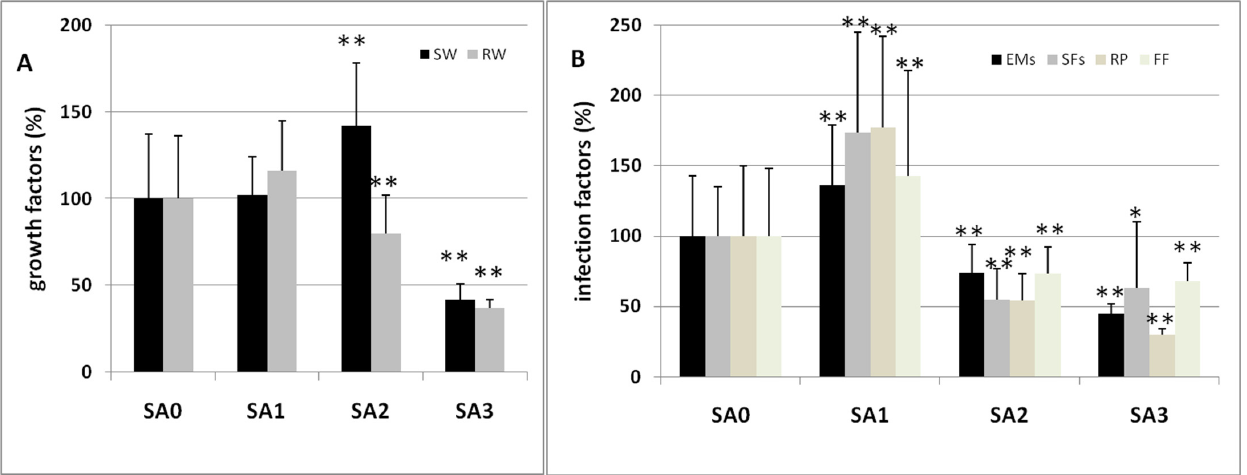
Figure 3. Effects of sprayed SA on plant growth ( A ) and nematode infection ( B ) in tomato plants 40 days after M. incognita inoculation. Growth factors were shoot (SW) and root (RW) weights. Infection was evaluated by the numbers of egg masses (EMs) per root system, the numbers of sedentary forms (SFs) per root system, reproduction potential (RP), and female fecundity (FF). Values for SA-treated plants are expressed in percentages with respect to untreated plants (set at 100%—SA0). Values ± standard deviations of controls were statistically differentiated from those of treatments by a paired t -test ( * p < 0.05; ** p < 0.01). Dose ranges are expressed as mg SA g − 1 plant fresh weight